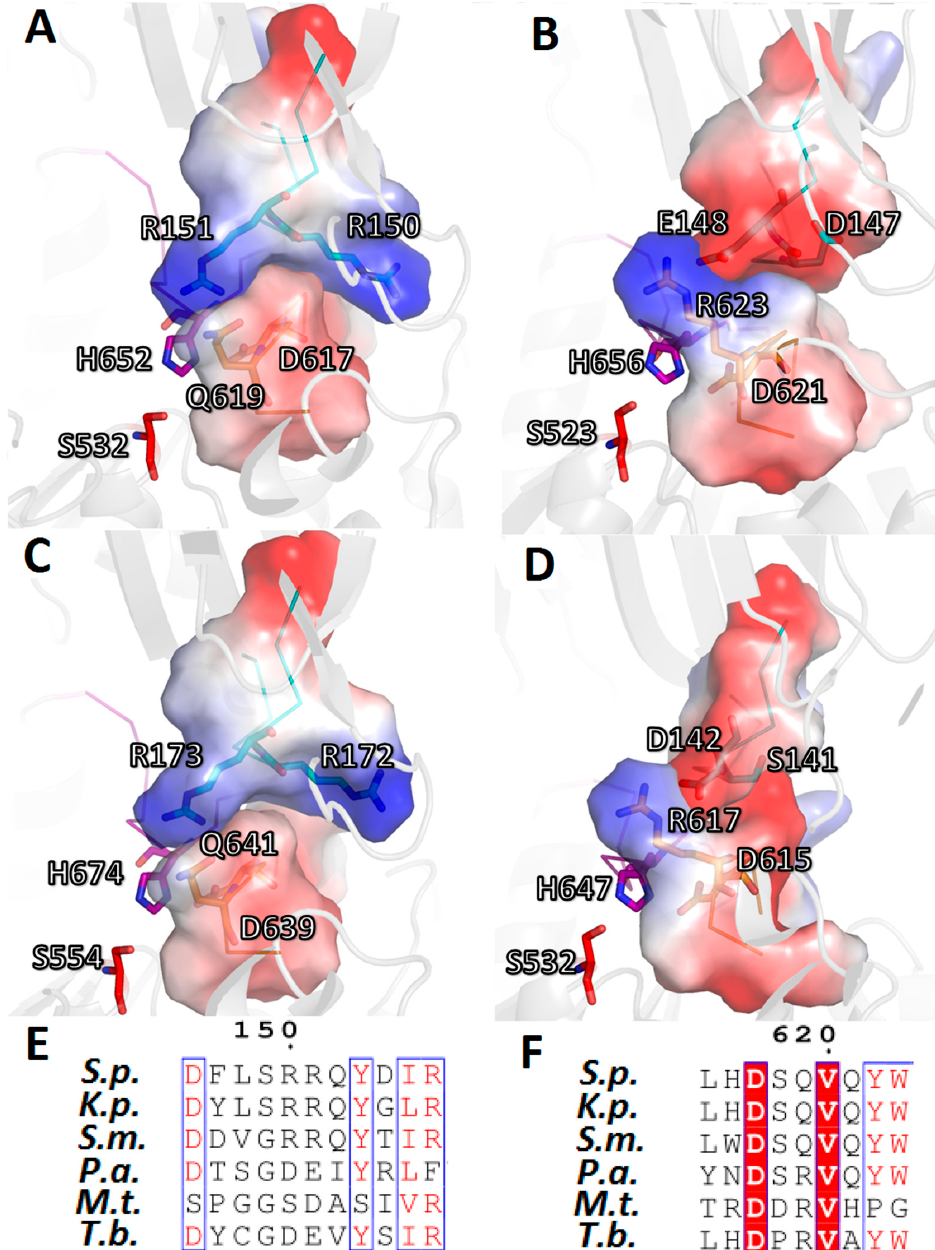
Figure 9. Two modes of stabilization of the catalytic triads in the AlphaFold-built models of bacterial OpBs from nosocomial pathogens. Electrostatic interactions between D-loops of the catalytic domains and its opposite partner-loops (R/E-loops) of the β -propeller domains are shown as cartoon/surface presentations for: ( A ) K. pneumoniae (K.p.), ( B ) P. aeruginosa (P.a.), ( C ) S. maltophilia (S.m.), ( D ) M. tuberculosis (M.t.). The H-, D-, and R/E-loops are in magenta, gold, and cyan, respectively. Amino acid residues 615–621 (K.p.), 619–625 (P.a.), 637–643 (S.m.), and 613–619 (M.t.) from D-loops, as well as 146–154 (K.p.), 143–151 (P.a.), 168–176 (S.m.), and 137–145 (M.t.) from R/E-loops, are shown as surfaces and colored according to their electrostatic potential. Positive and negative charges are in blue and red, respectively. The color scale is in units of kT/e ranging from − 50 to +50. ( E , F ) The amino acid alignments of R/E- and D-loops, respectively. Highly conserved residues are highlighted in red, semi-conserved are colored in red. The corresponding sequences from SpOpB (S.p.) and TbOpB (T.b.) are included for comparison. Numbering is according to the SpOpB